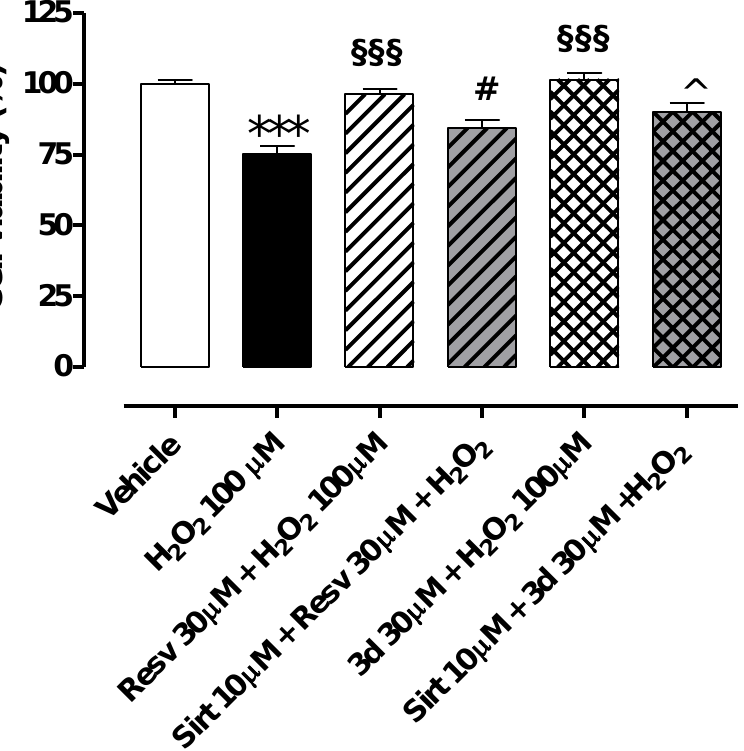
Figure 8. Preventive effects of resveratrol and compound 3d against H 2 O 2 -induced reduction in cell viability: Potential role of sirtuins. Bars indicate cell viability (%) of HUVECs treated with H 2 O 2 100 µ M for 2 h. In the absence of the sirtuin inhibitor sirtinol (Sirt 10 µ M), both resveratrol (Resv) and compound 3d (30 µ M), incubated for 1 h, significantly protected endothelial cells from pro-oxidative cell damage. Conversely, in the presence of Sirt 10 µ M, the preventive effects of resveratrol and compound 3d against H 2 O 2 -induced reduction in cell viability were significantly reduced. Data are shown as mean ± SEM. * indicates significant difference vs. vehicle (*** p < 0.001), § indicates signif- icant difference vs. H 2 O 2 100 µM (§§§ p < 0.001), # indicates significant difference vs. Resv 30 µM + H 2 O 2 100 µM (# p < 0.05) while ^ indicates significant difference vs. 3d 30 µM + H 2 O 2 100 µM (^ p <